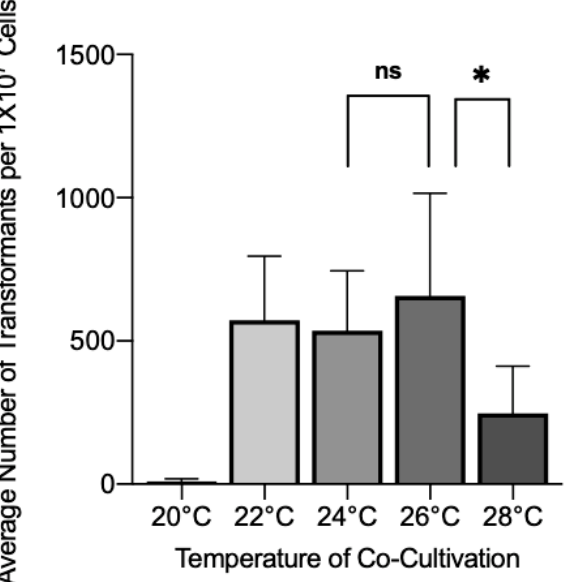
Figure 2. Wild-type C. glabrata was co-cultivated with A. tumefaciens containing plasmid p624 for 72 h at a variety of temperatures to determine the optimal temperature for transformant yield. Brackets with * above bars indicate groups with statistically significant differences. No significant difference indicated with ns. ns = p > 0.05, * = p ≤ 0.05.